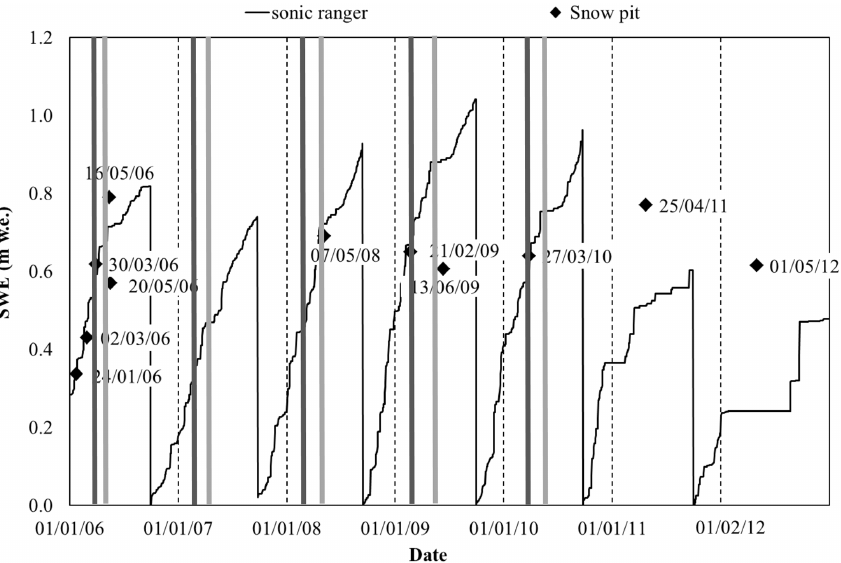
Figure 2. Comparison between SWE measured by sonic ranger and by snow pit from 2006 to 2012. The beginning of the snow melting and the actual snow ablation is shown by light-grey and dark-grey lines, respectively.